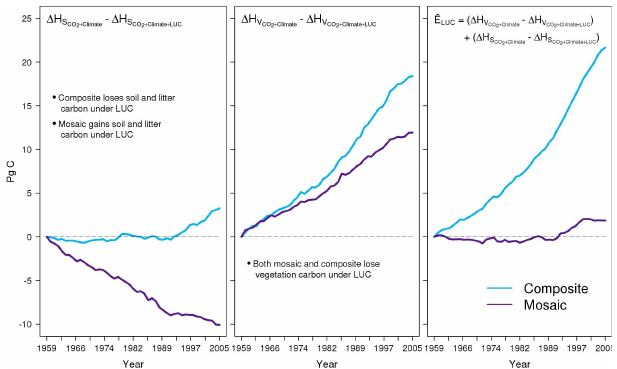
Fig. 9. Global response to LUC for the composite and mosaic ap- proaches over the 1959–2005 period. The difference between the simulations with LUC (Climate+LUC+CO 2 ) and without LUC (Climate+ CO 2 ) for the cumulative change in the soil and litter ( 1H S ) (left panel) and vegetation pools ( 1H S ) (centre panel) are defined following Eq. (9). The cumulative LUC emissions ( ˜ E LUC ) for the composite and mosaic approaches is shown in the right panel as the additive result of the left and centre